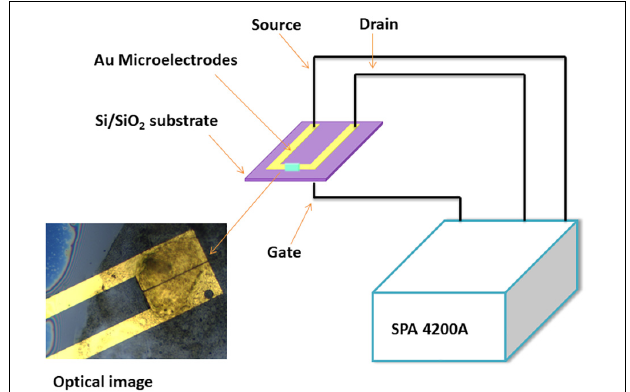
FIGURE 1 | Schematic and optical image for a single microelectrode, drop casted with Ni 3 BTC 2 /OH-SWNTs material.